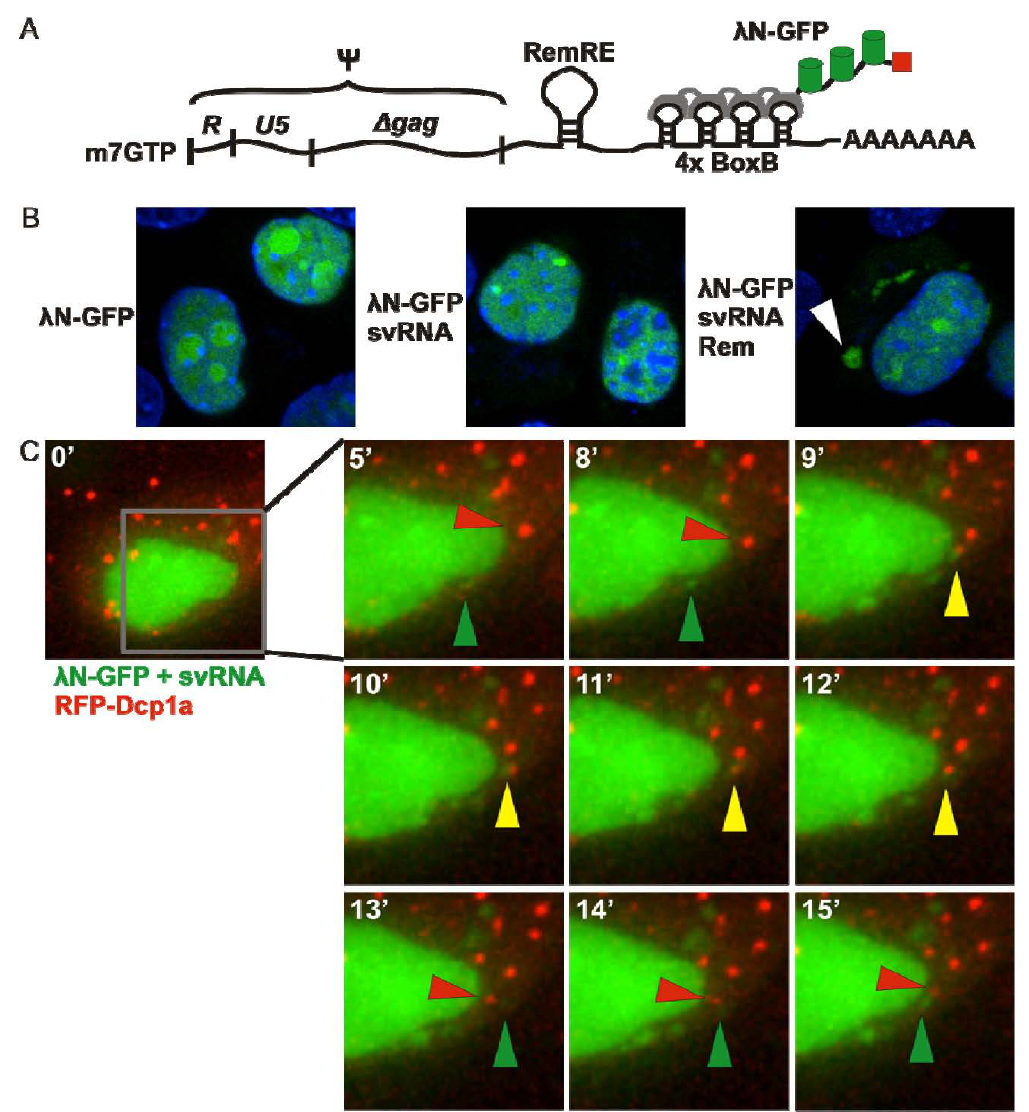
Figure 1. Localization of mouse mammary tumor virus (MMTV) RNA with P-body proteins. ( A ) Diagram of MMTV subviral RNA containing the MMTV packaging signal -GFP (  ), the Rem response element (RemRE), and 4 BoxB loops bound by the  N -GFP alone (left);  -GFP and svRNA reporter. ( B ) NMuMG cells transfected with  N N -GFP, svRNA, and Rem (right). Fixed cells were imaged using a Leica SP2 (middle); or  N -GFP bound to confocal microscope. White arrow indicates cytoplasmic accumulation of  N svRNA. ( C ) Live-cell co-imaging of MMTV svRNA and RFP-Dcp1a in NMuMG cells. Green arrows indicate svRNA alone; red arrows indicate RFP-Dcp1a alone; yellow arrows indicate colocalization between the svRNA and